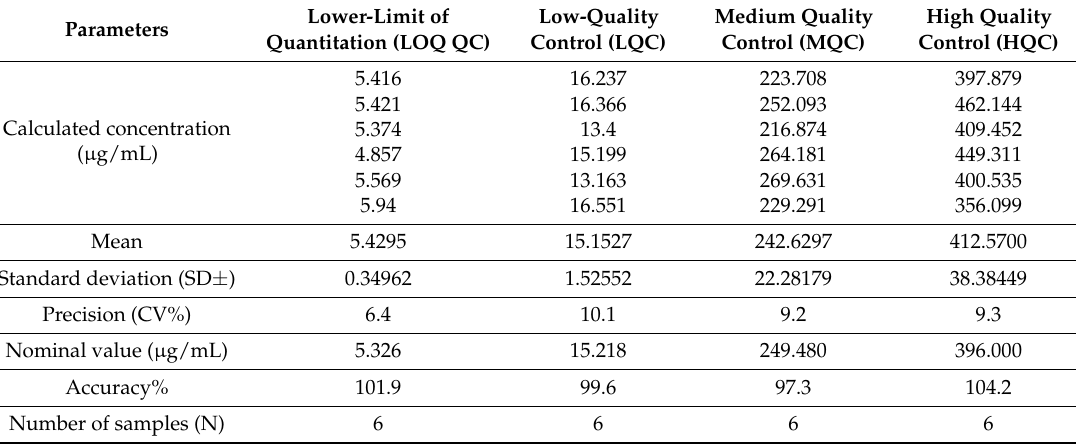
Table 3. Precision and accuracy of LC-MS/MS